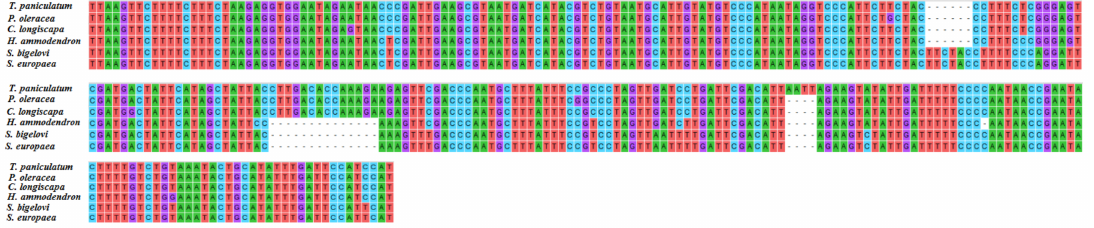
Figure 5. The gene of rpl23 sequence alignment among six Caryophyllales